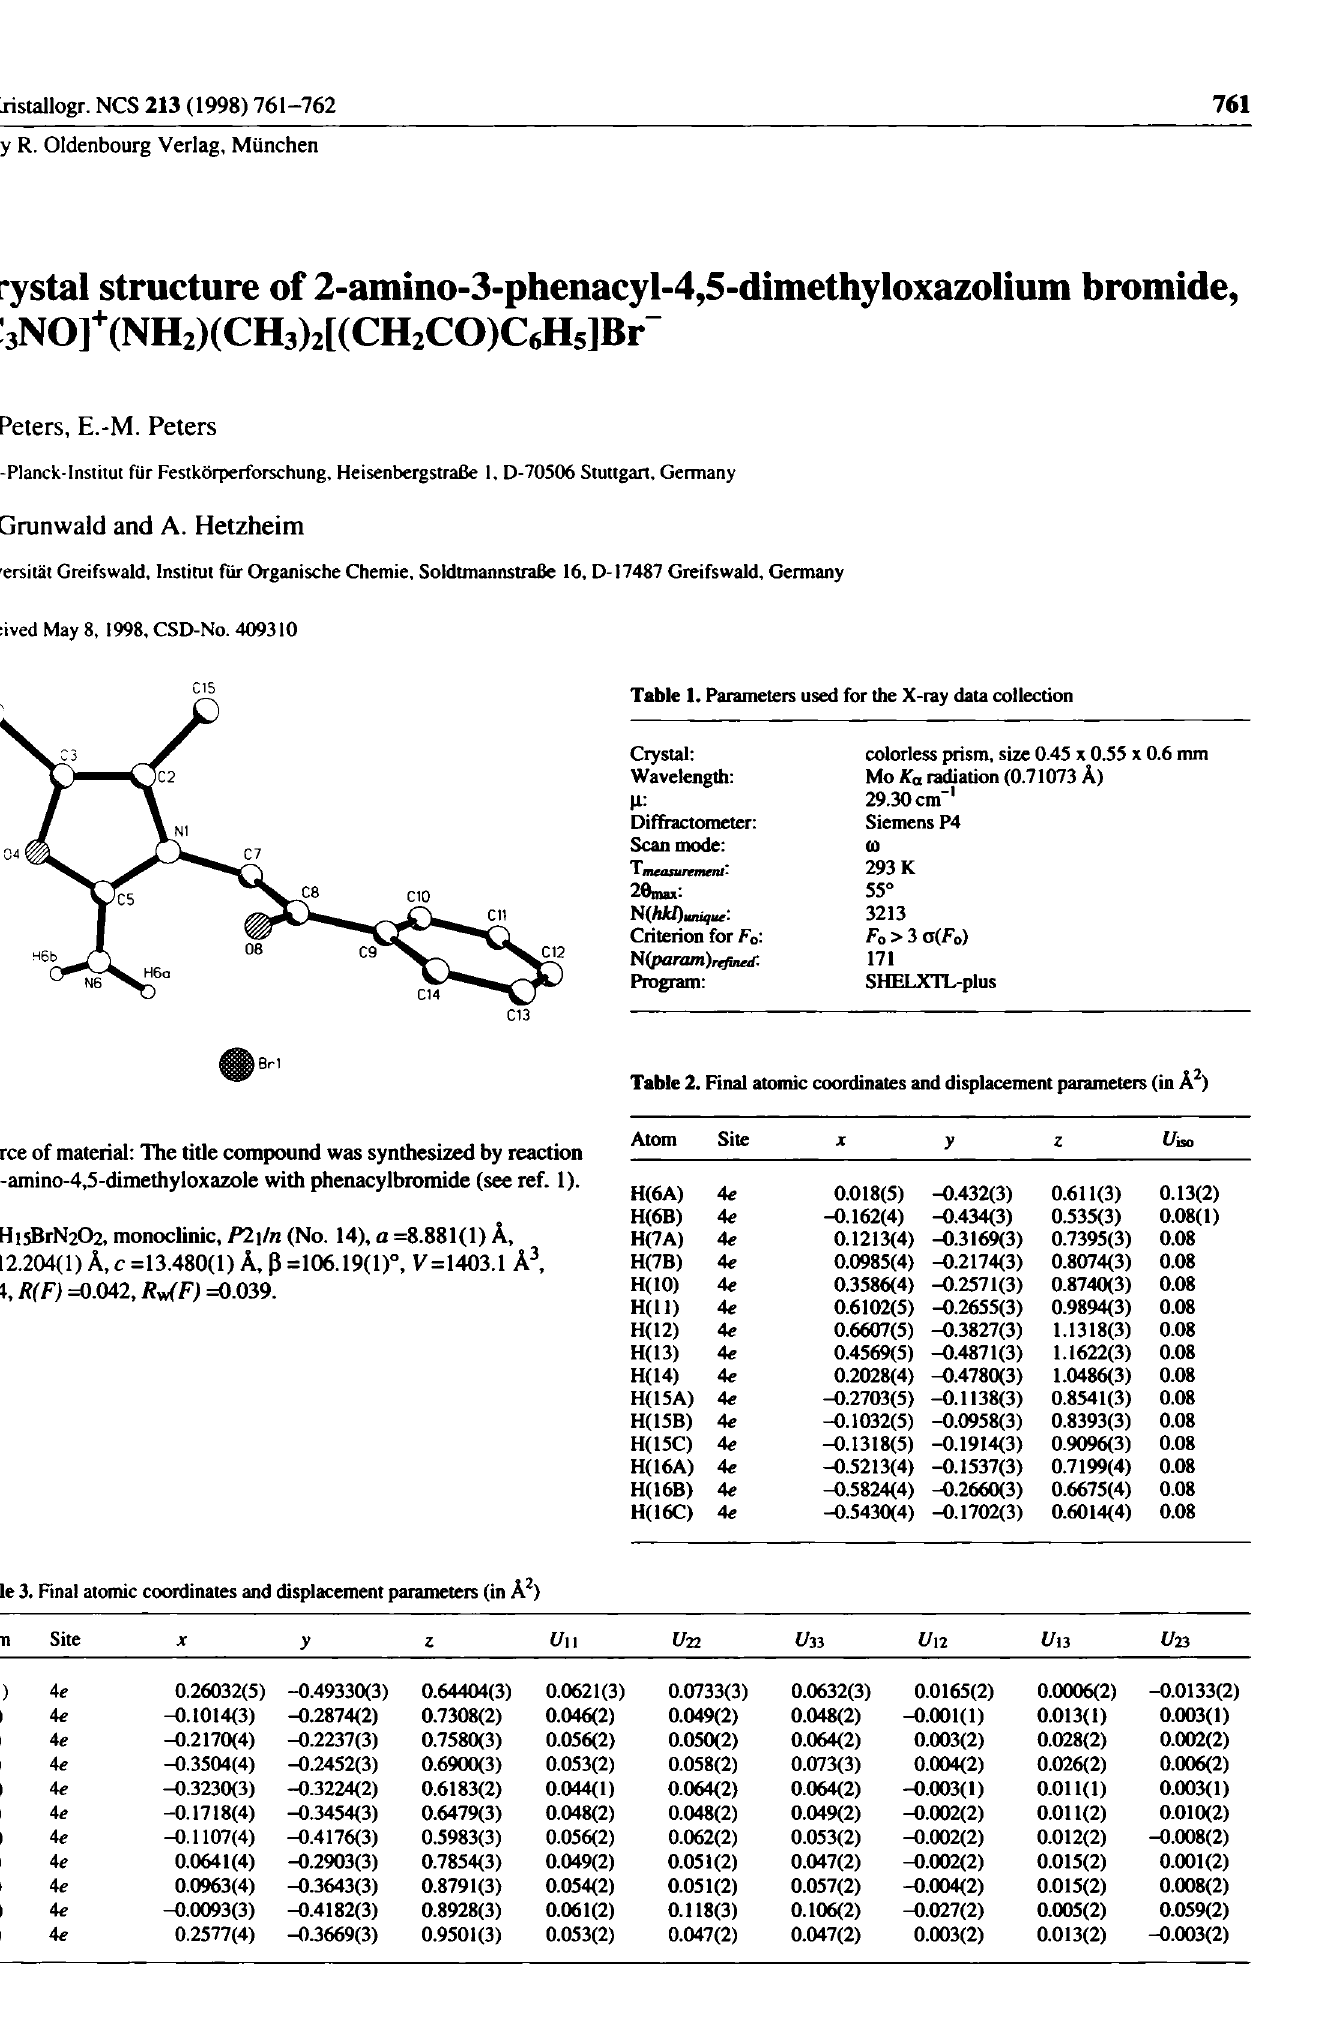
Table 3. Final atomic coordinates and displacement parameters (in Â^)